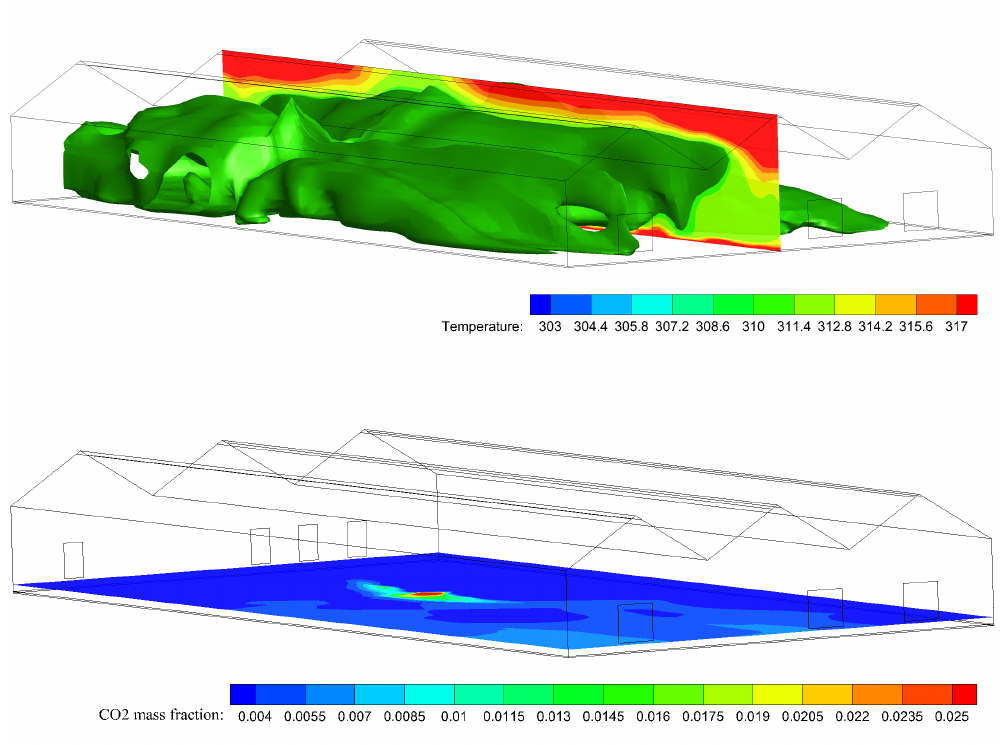
Figure 14. Resulted temperature contour at center Z plane combined with iso-surface of 311 K ( top ), and CO 2 fraction distribution at 0.3 m height (Y plane, bottom